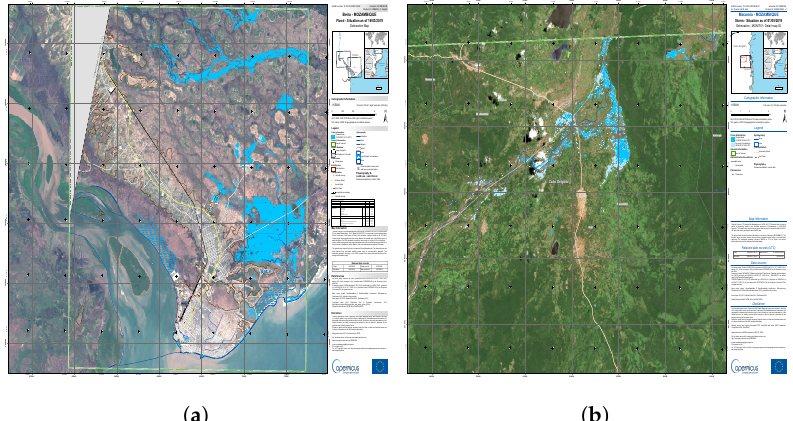
Figure 5. Copernicus EMS maps for Beira on 16 March 2019 ( a ), and for Macomia on 1 May 2019 ( b ). https://emergency.copernicus.eu/mapping/list-of-activations-rapid, Accessed: 20 July 2022. ( a ) Beira. ( b ) Macomia.